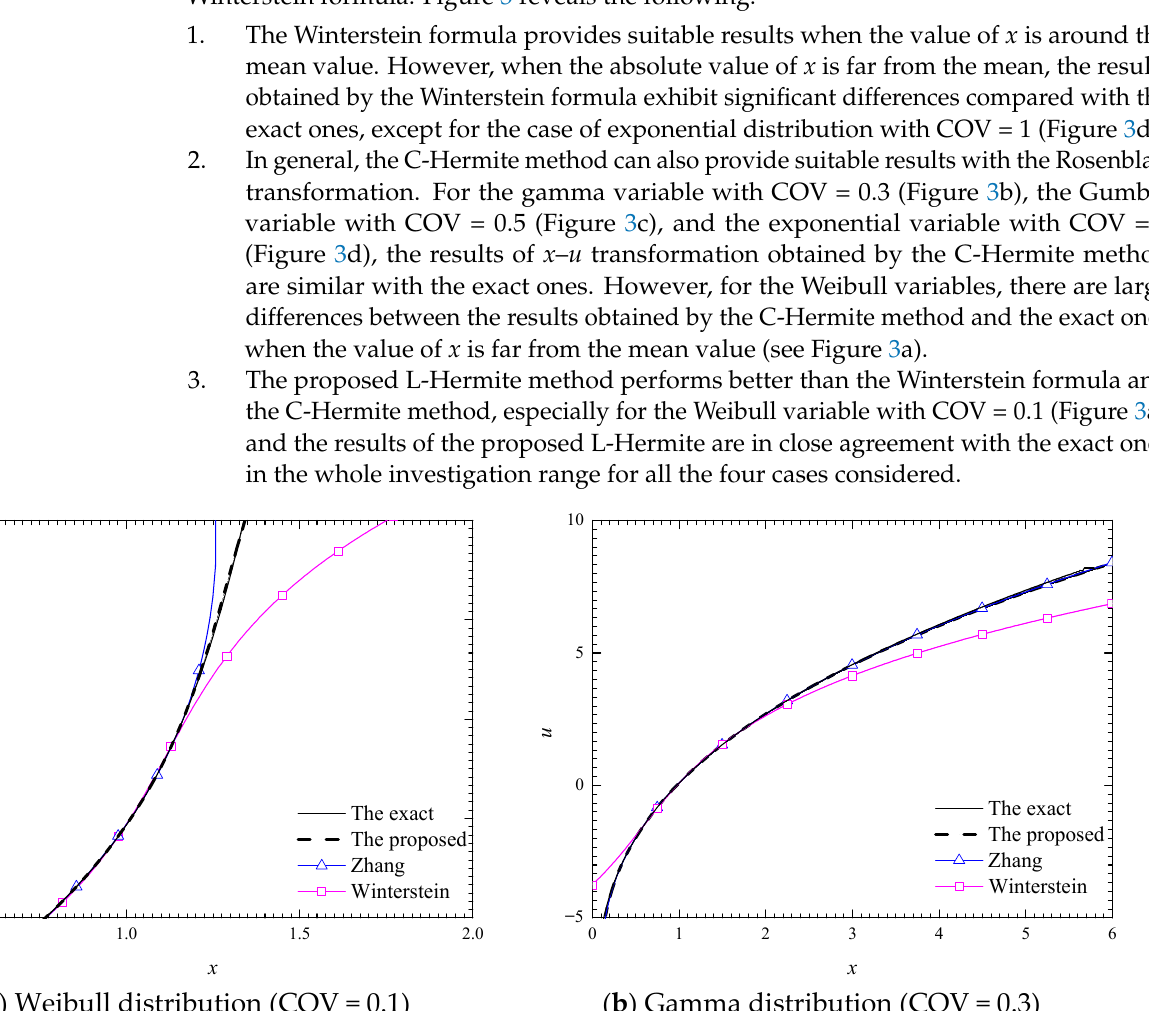
Table 2. Probability distributions and their statistical parameters for Example 1.